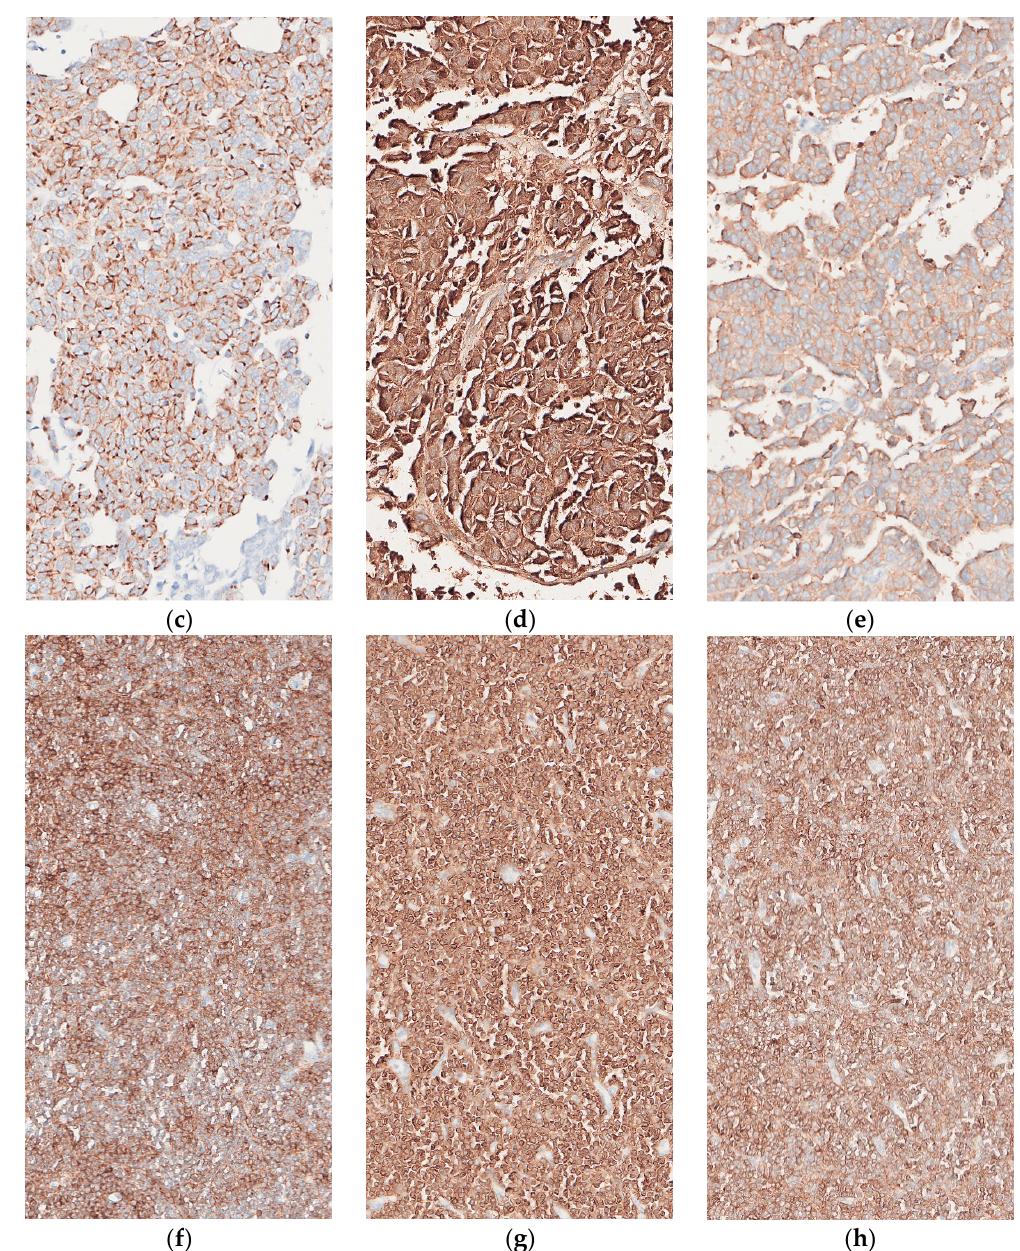
Figure 1. Case 1: ( a ) Left parotid mass showing high-grade neuroendocrine carcinoma composed of small nests and larger aggregates of tumor cells with frequent apoptotic cells and a high mitotic activity. ( b ) Left superior cervical lymph node with abnormal morphology showing diffuse effacement of the normal architecture due to extensive replacement by small, atypical lymphocytes. (H&E; original magnification: ( a ) 20×; ( b ) 7×). Immunohistochemical stains of left parotid mass ( c – e ) and left superior cervical lymph node ( f – h ). ( c ) CK20 showing dot-like positivity in tumor cells (Magnification 20×). ( d ) Neuron-specific enolase (NSE) diffusely staining tumor cells (Magnification 20×). ( e ). Synaptophysin showing tumor cells with focal membranous positivity (Magnification 20×). ( f ) CD20 diffusely highlights atypical B lymphocytes (Magnification 20×). ( g ) CD5 showing aberrant staining of neoplastic B lymphocytes (Magnification 20×). ( h ) CD23 showing membranous positivity in neoplastic B lymphocytes (Magnification 20×).